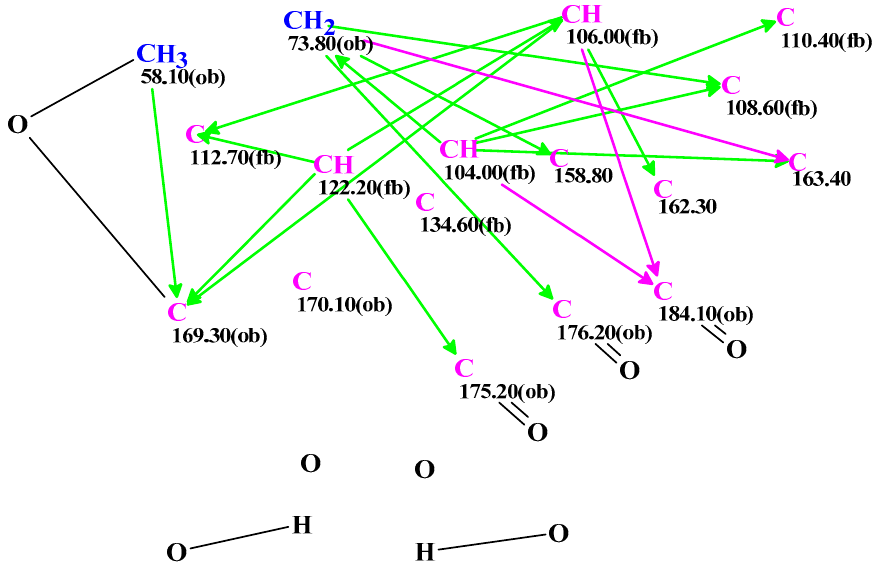
Figure 4. Molecular Connectivity Diagram obtained from the NMR data of ominoxanthone (C 17 H 10 O 8 ) recorded in TFA- d . Carbons hybridized as sp 3 and sp ² are respectively written in navy blue and violet. The admissibility of a neighbor heteroatom is indicated by the labels « ob » (oblig- atory) and « fb » (forbidden). HMBC connectivities are indicated by green arrows. Violet arrows refer to nonstandard correlations (length n > 3, for n J HH,CH ). These correlations were set for the weak HMBC signals.